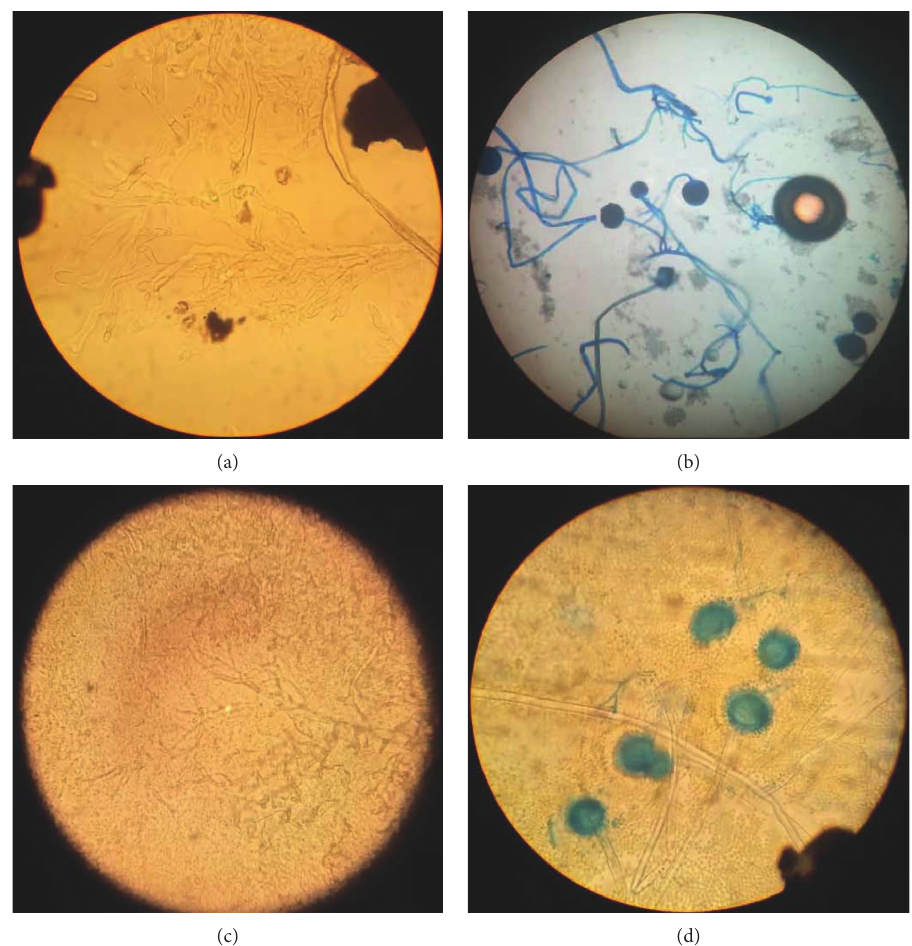
Figure 2: Direct smear revealed hyphae with characteristics consistent with Mucorales (a). The result of microscopic examination of cultured fungi was consistent with Rhizopus arrhizus (b). Direct smear revealed hyphae with characteristics consistent with Aspergillus species (c). The result of microscopic examination of cultured fungi showed Aspergillus flavus